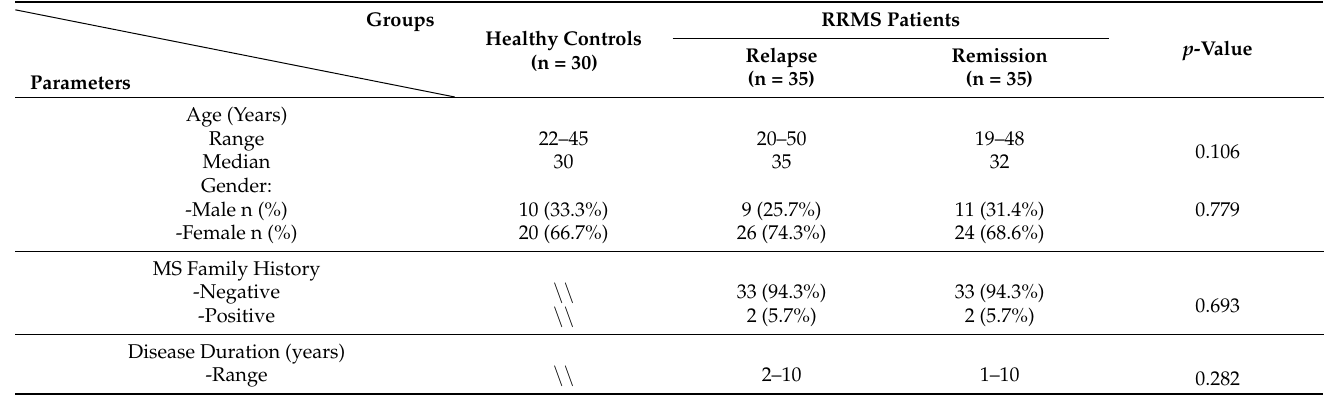
Table 1. Demographic and clinical characteristics of the studied